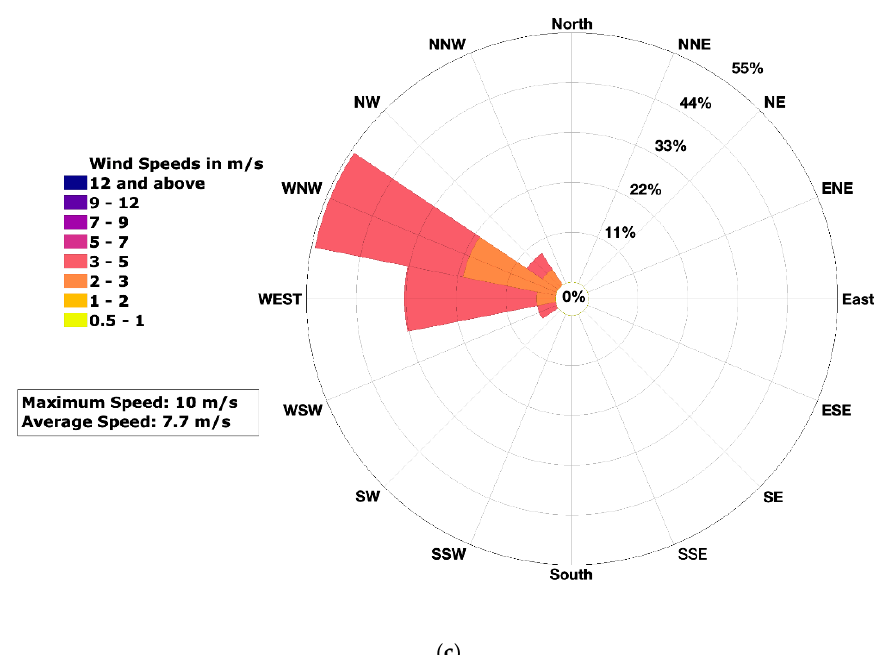
Figure 9. Wind roses for ( a ) 11 June, ( b ) 12 June, and ( c ) 13 June, providing details of the percentage (%) frequency of the wind speed from a direction as recorded at the TCEQ CAMS 12 (UTEP) during the back-to-back low ozone episodes. Each color represents wind intensities as follows: navy blue: 12 and above m/s; violet: 9–12 m/s; purple: 7–9 m/s; magenta: 5–7 m/s; red: 3–5 m/s; orange: 2–3 m/s; amber: 1–2 m/s and yellow: 0.5–1 m/s.